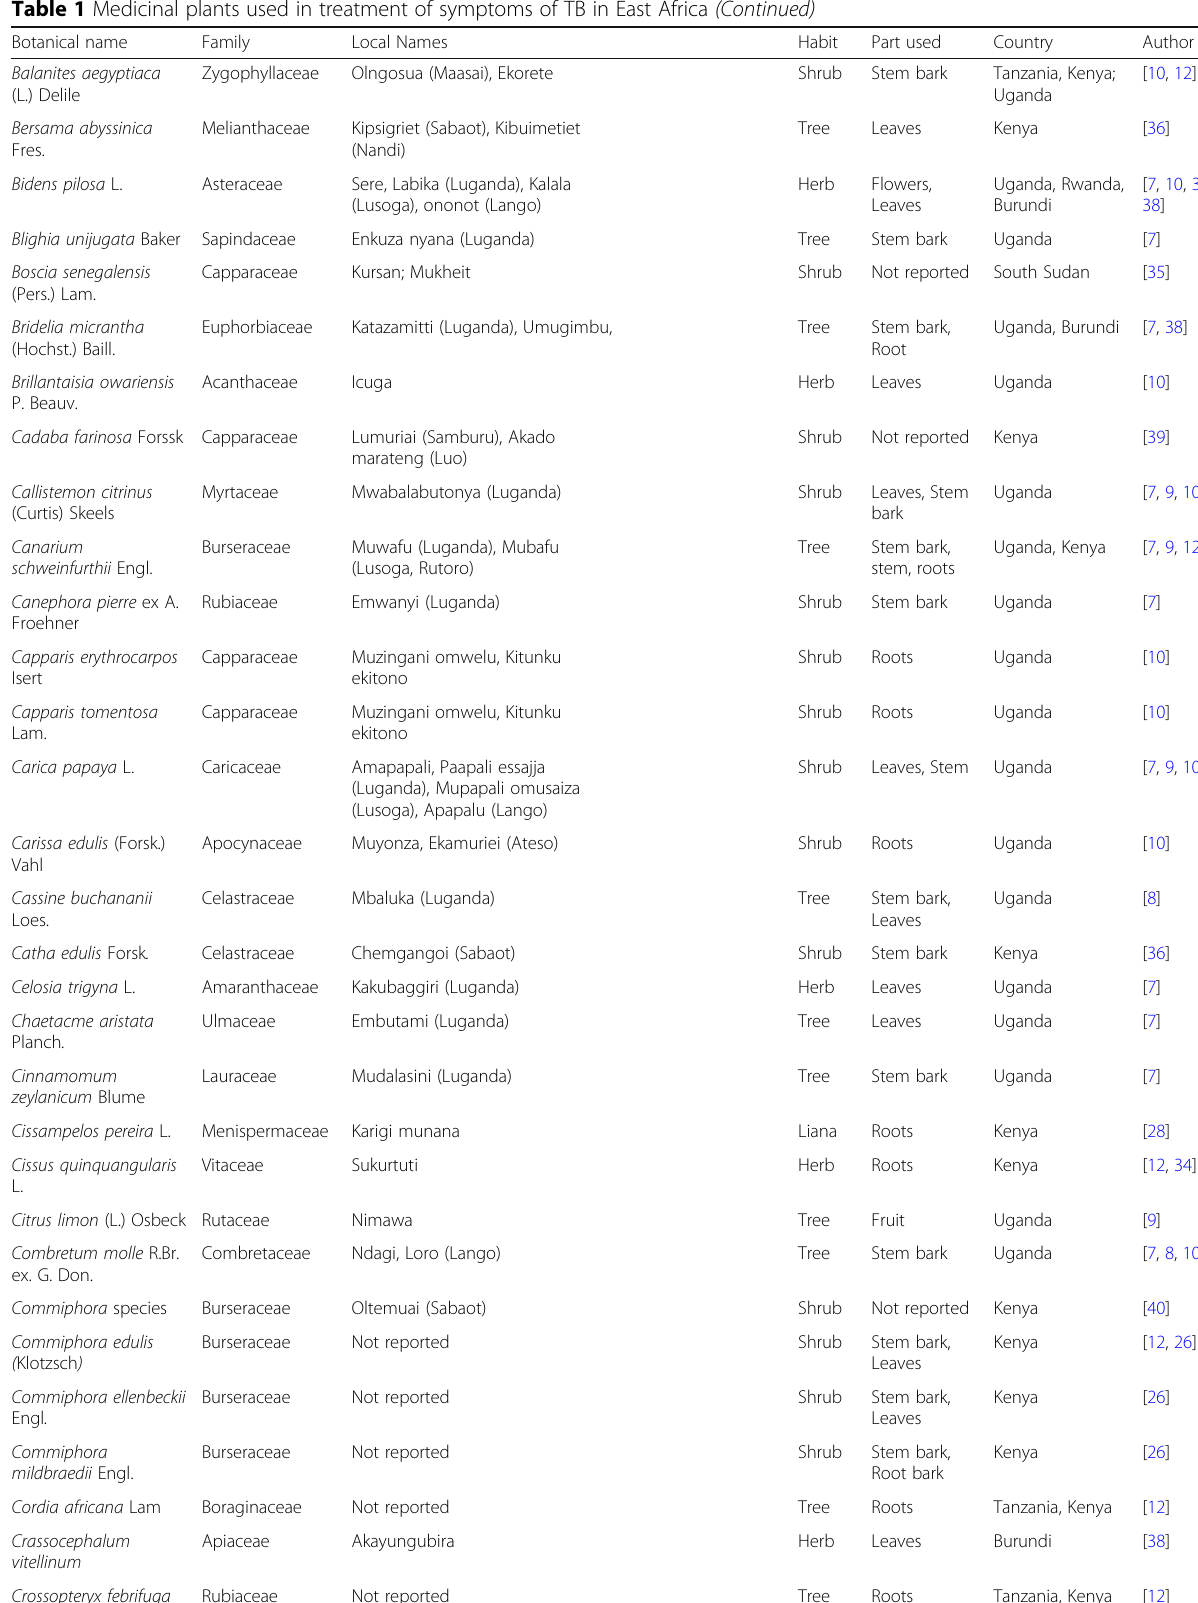
Table 1 Medicinal plants used in treatment of symptoms of TB in East Africa